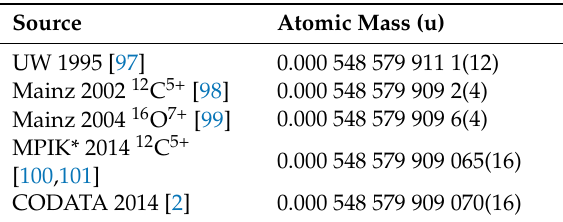
Table 10. Atomic mass values for the